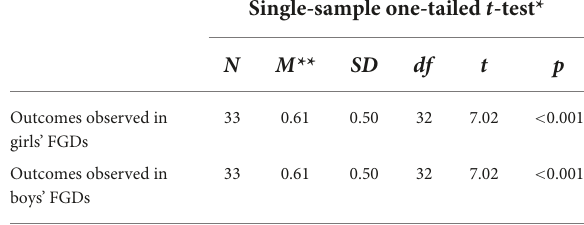
TABLE 7 T -test results comparing observed outcomes to null